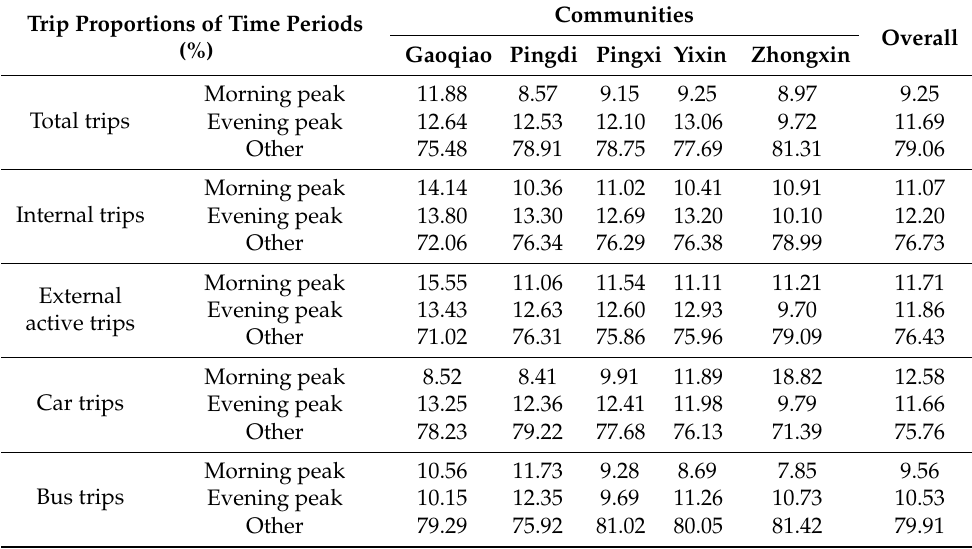
Table 5. Estimated trips in different time periods of the ILCC Core Area in 2016.